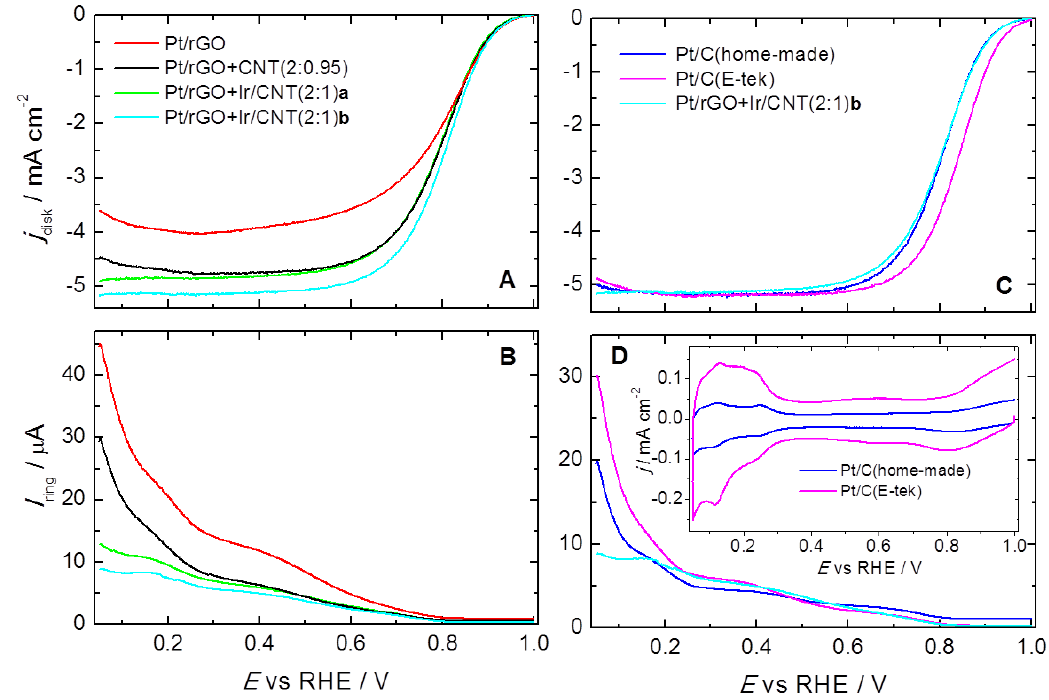
Figure 5. Normalized (background subtracted) rotating disk ( A , C ) and ring ( B , D ) voltammograms recorded during oxygen reduction at the catalytic films (described in the text) in oxygen-saturated 0.5-mol dm − 3 H 2 SO 4 at the scan rate of 10 mV s − 1 and rotation rate of 1600 rpm. Inset to Figure 5D shows cyclic voltammetric responses recorded for Pt/C (home-made) and Pt/C (E-tek) catalysts in nitrogen-saturated 0.5-mol dm − 3 H 2 SO 4 at the scan rate of 10 mV s − 1 .